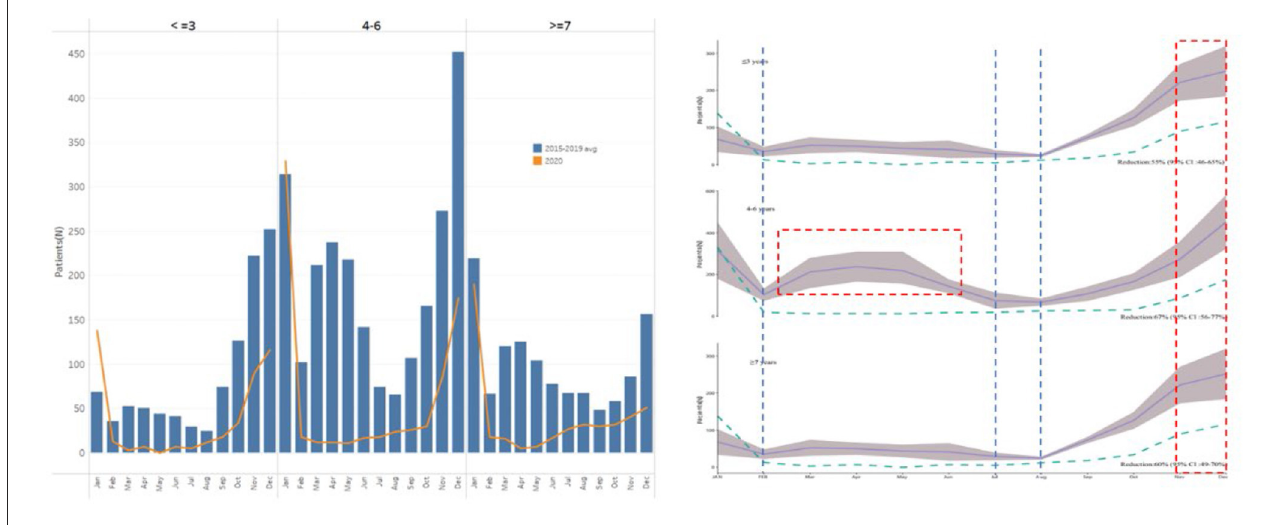
FIGURE4 Age-dependent analysis of AOM epidemiological trends in 2015–2020. The higher outpatient rates of AOM were marked in red line; while lower AOM outpatient records were marked in blue